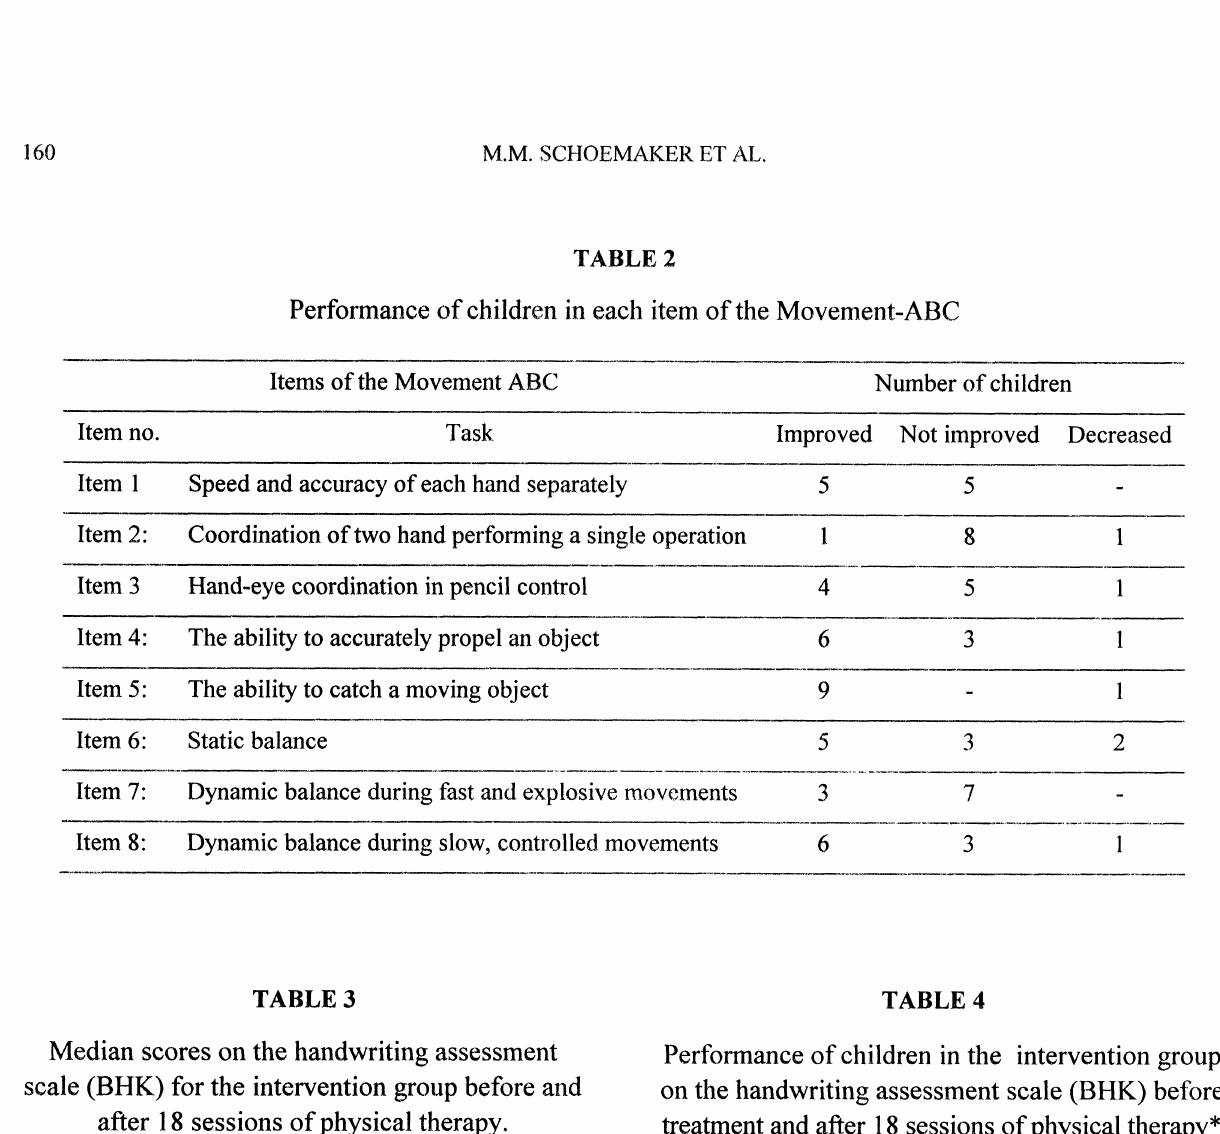
Performance of children in the intervention group on the handwriting assessment scale (BHK) before treatment and after 18 sessions of physical